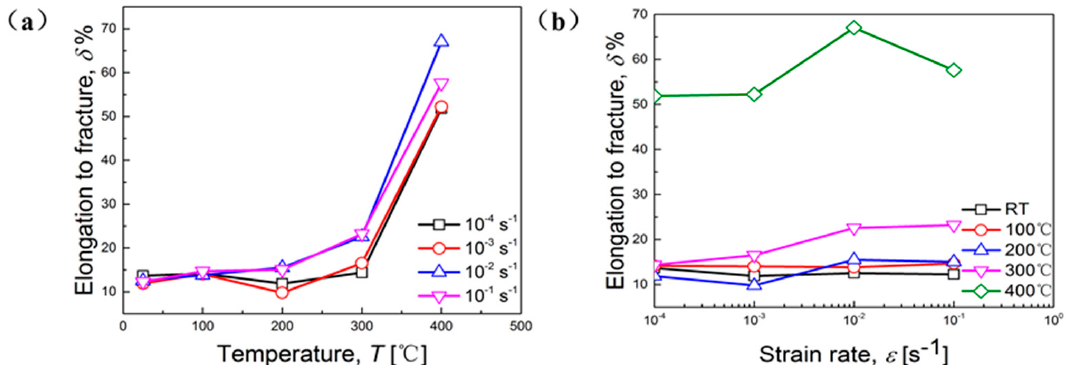
Figure 4. Elongation to fracture as a function of: ( a ) Temperature; ( b ) strain rate.